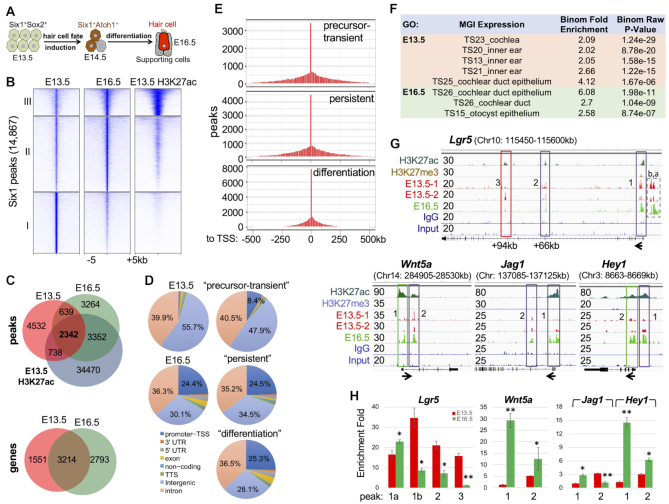
Six1 binding is dynamic across the transition of prosensory precursors to hair-bundle development. (A) Schematic drawing of time course of cochleae for ChIP-seq analysis. (B) Clustered heatmaps of Six1 and H3K27ac within a −5 kb/+ 5 kb window centered on all 14 867 Six1 peaks in E13.5 and E16.5 cochlea and overlapping with the deposition of H3K27ac in E13.5 cochlear epithelium. Peaks were called with the MACS program with a P value cut-off of 1e–5. (C) A Venn diagram indicating overlap of Six1-binding sites of E13.5 and E16.5 and of H3K27ac-deposition at E13.5. Lower panel indicating overlap of Six1-associated genes between E13.5 and E16.5. (D) Genomic distribution of Six1-enriched regions. (E) Distribution of Six1 peaks relative to TSSs. (F) GREAT analysis showing association of Six1-enriched regions with terms in the mouse gene expression information (MGI) database. (G) Genome browser visualization of Six1 peaks at Lgr5, Wnt5a, Jag1 and Hey1. y-Axis numerical values in each track indicate track height scaling in read depth. The direction of transcription is shown by the arrow beginning at the TSS. (H) ChIP-qPCR analysis of the boxed peaks in (G) confirming stage-related changes in Six1-binding. IPs and mock IPs (IgGs) were normalized to inputs and the enrichment of mock IP was considered 1-fold (not shown). *P < 0.05, **P < 0.01.